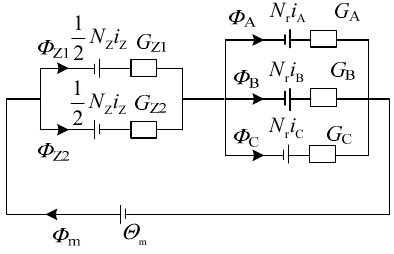
Figure 2. Equivalent magnetic circuit of three ‐ pole radial ‐ axial hybrid magnetic bearings (HMB).